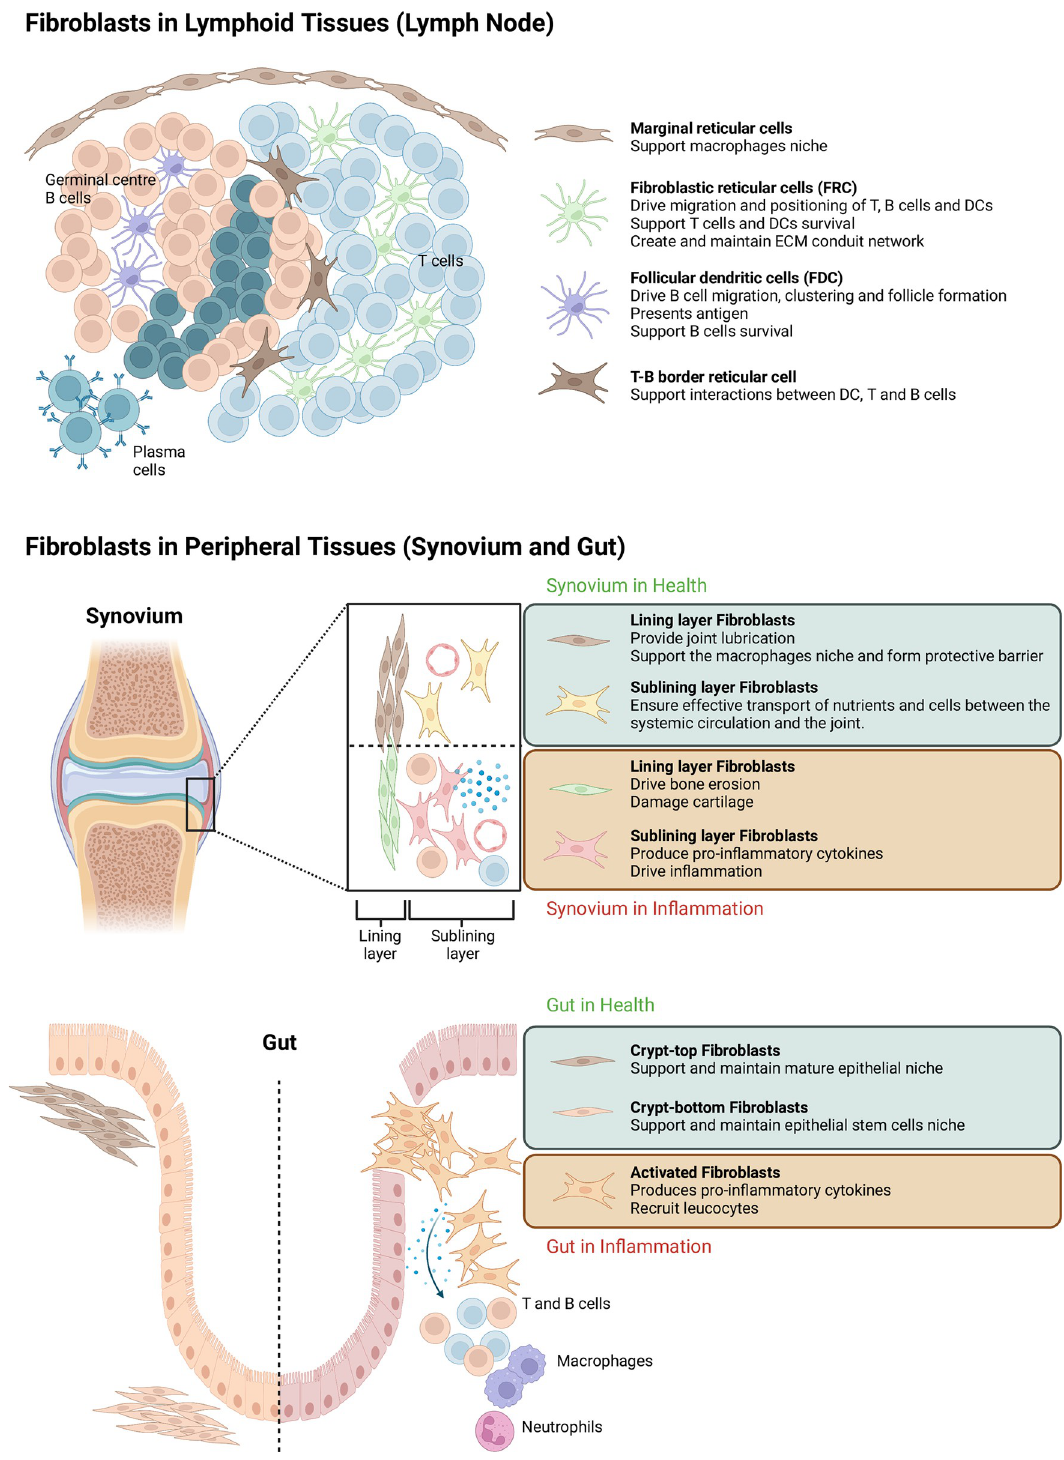
Fig 3. Fibroblasts in lymphoid and peripheral tissues. Fibroblasts have different roles in the lymphoid and peripheral tissues. They mainly define and maintain cellular niches within the tissue microenvironment to ensure smooth functioning of the tissues, but when they go rogue, they can drive tissue damage and orchestrate pathological inflammation. Figure is created with BioRender.com.